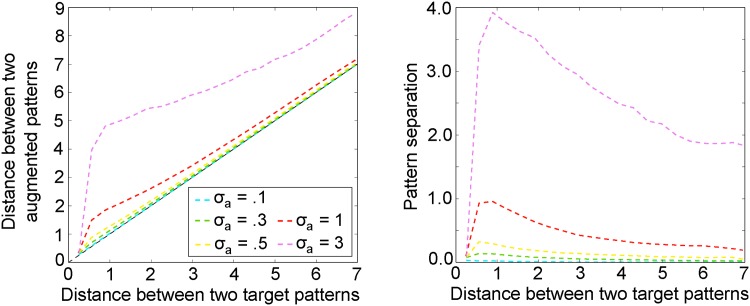
Augmentation with pattern separation vector leads to pattern separation.Left: The distance between pairs of augmented patterns (Da), i.e., containing the pattern separation vectors, against the distance between pairs of original patterns (Dt). A curve above the diagonal means that the augmented vectors and more dissimilar than the original vectors, indicative of pattern separation. Right: Same data as left panel, but plotted to emphasize pattern separation (= Da − Dt).